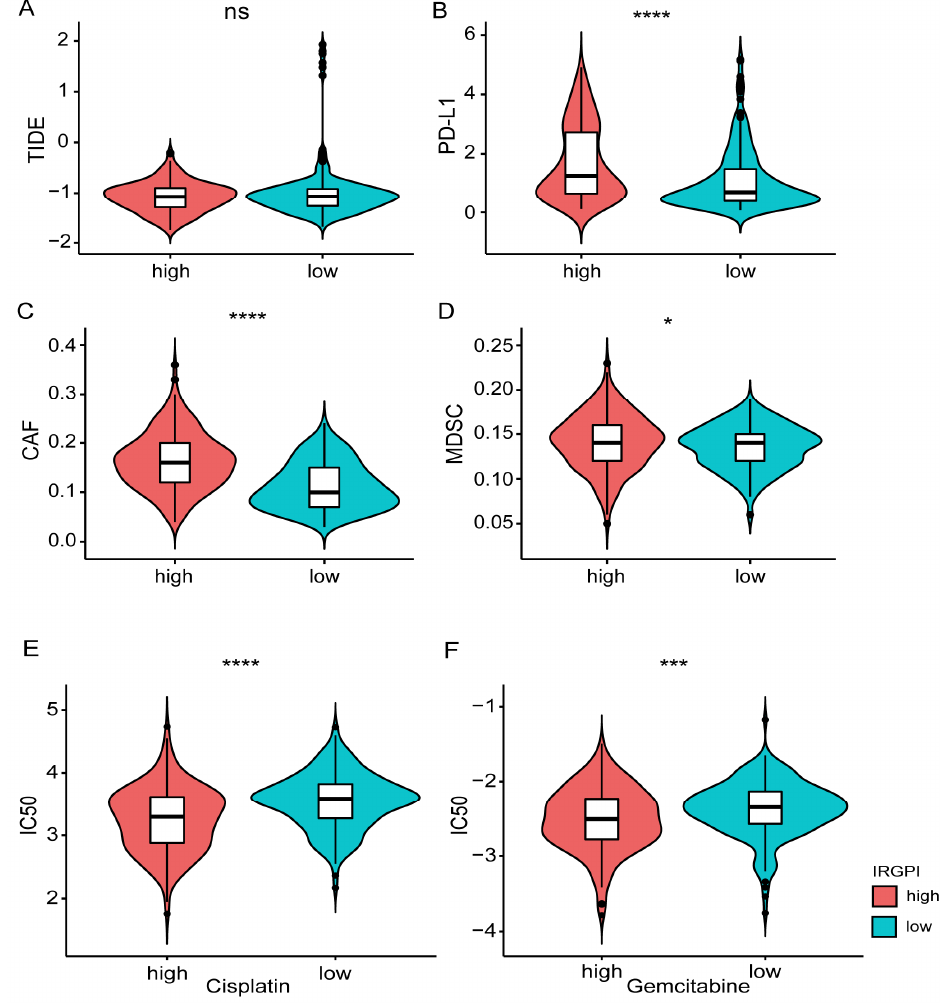
Figure 7. Prediction of the response to immunotherapy and platinum-based chemotherapy. ( A ) Comparison of immune checkpoint therapy efficacy based on the TIDE scores between different IRGPI groups. ( B – D ) Comparison of the expression of PD-L1, MDSC, CAFs between different IRGPI groups. ( E , F ) Comparison of the drug resistance (Cisplatin, Gemcitabine) between different IRGPI groups. * p < 0.05, *** p < 0.001, **** p < 0.0001.